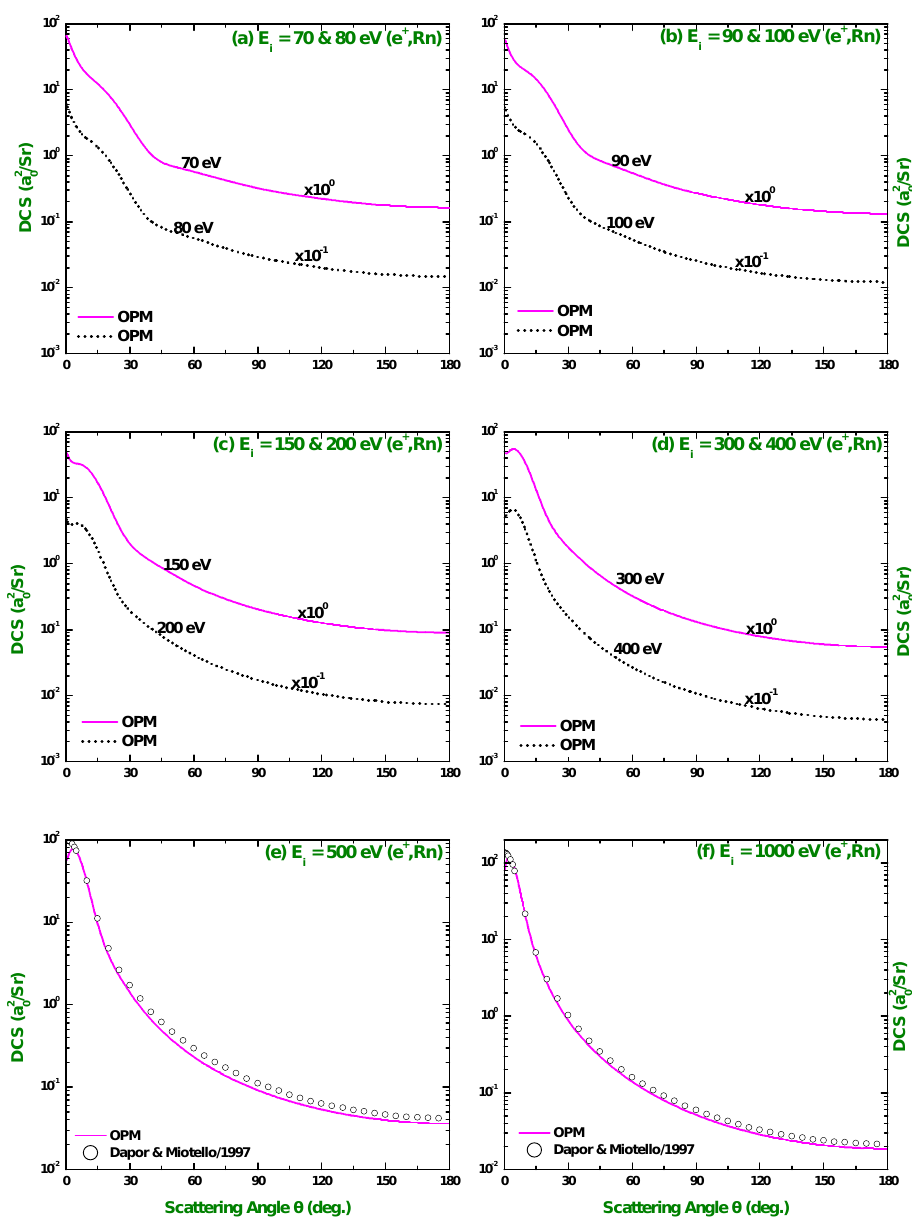
Figure 20. Same as Figure 19, but at impact energies of ( a ) 70 and 80 eV, ( b ) 90 and 100 eV, ( c ) 150 and 200 eV, ( d ) 300 and 400 eV, ( e ) 500 eV, and ( f ) 1000 eV. In addition, the calculations of Dapor and Miotello [21] at 500 and 1000 eV are